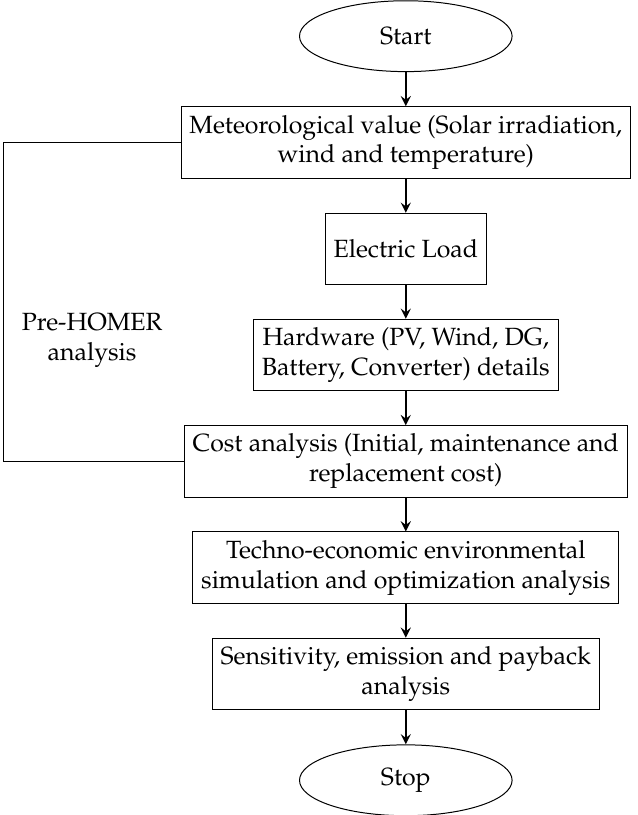
Figure 2. Research methodology of the proposed hybrid renewable energy system.